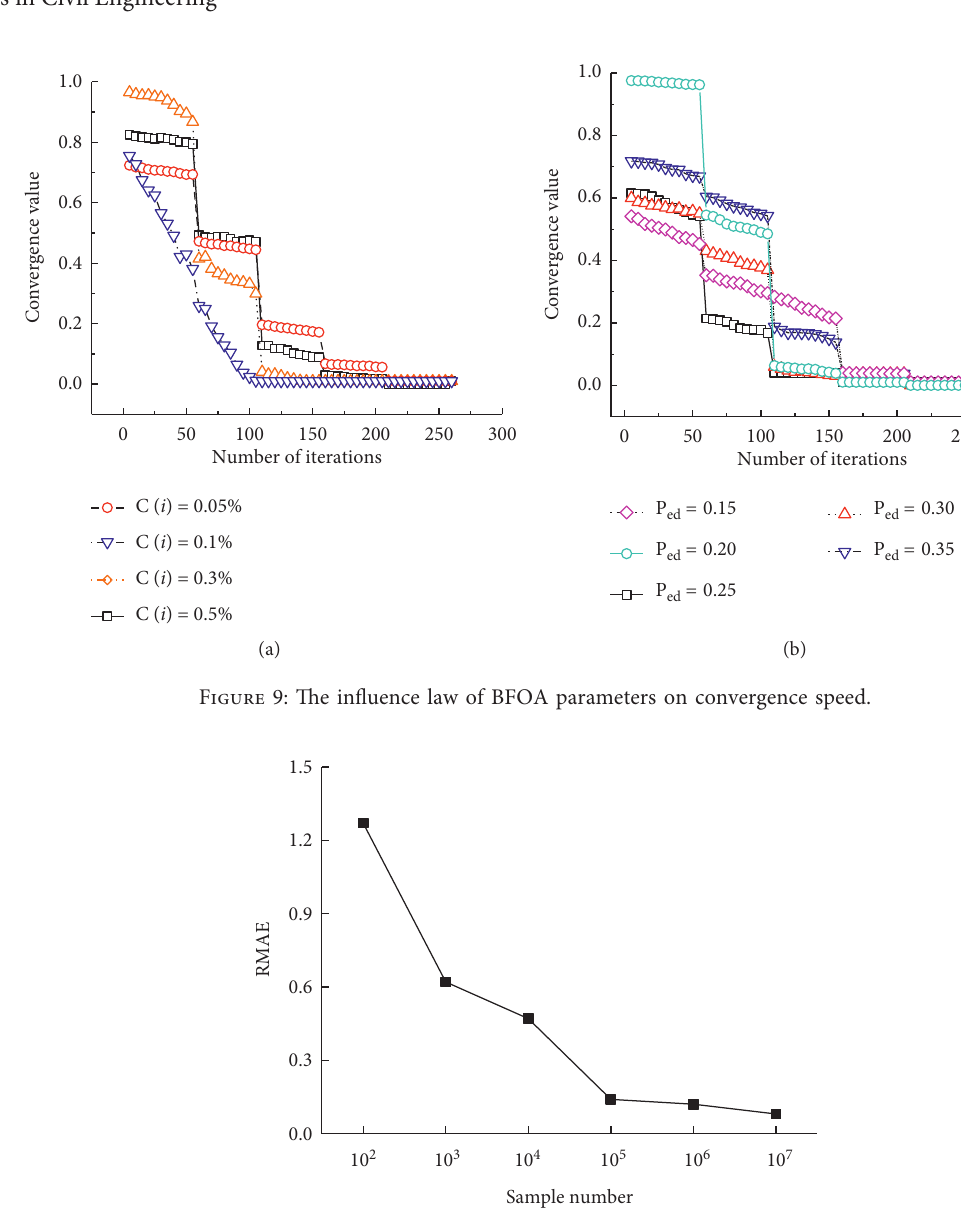
Figure 10: The influence law of Monte Carlo sample number.